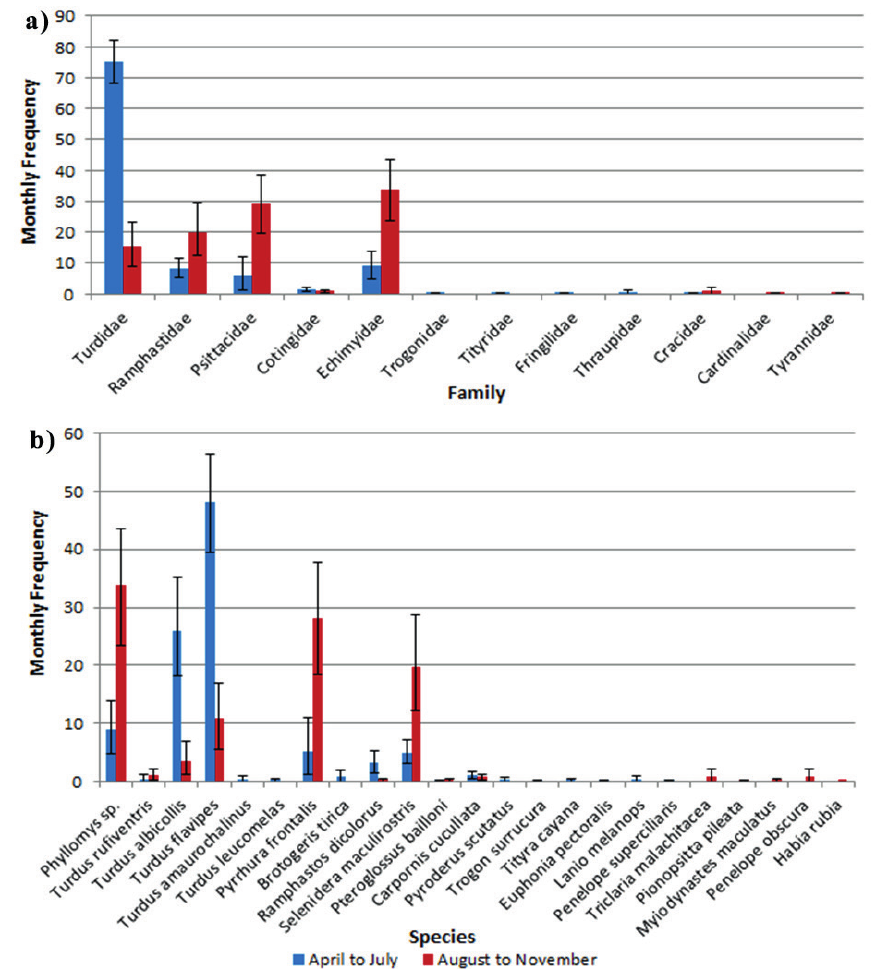
Figure 2 - Monthly average frequency of the: a) families and b) species recorded that fed on E . edulis infructescences during April to July and August to November during the 2013 and 2014 fruiting seasons. Confidence intervals (95 %) are